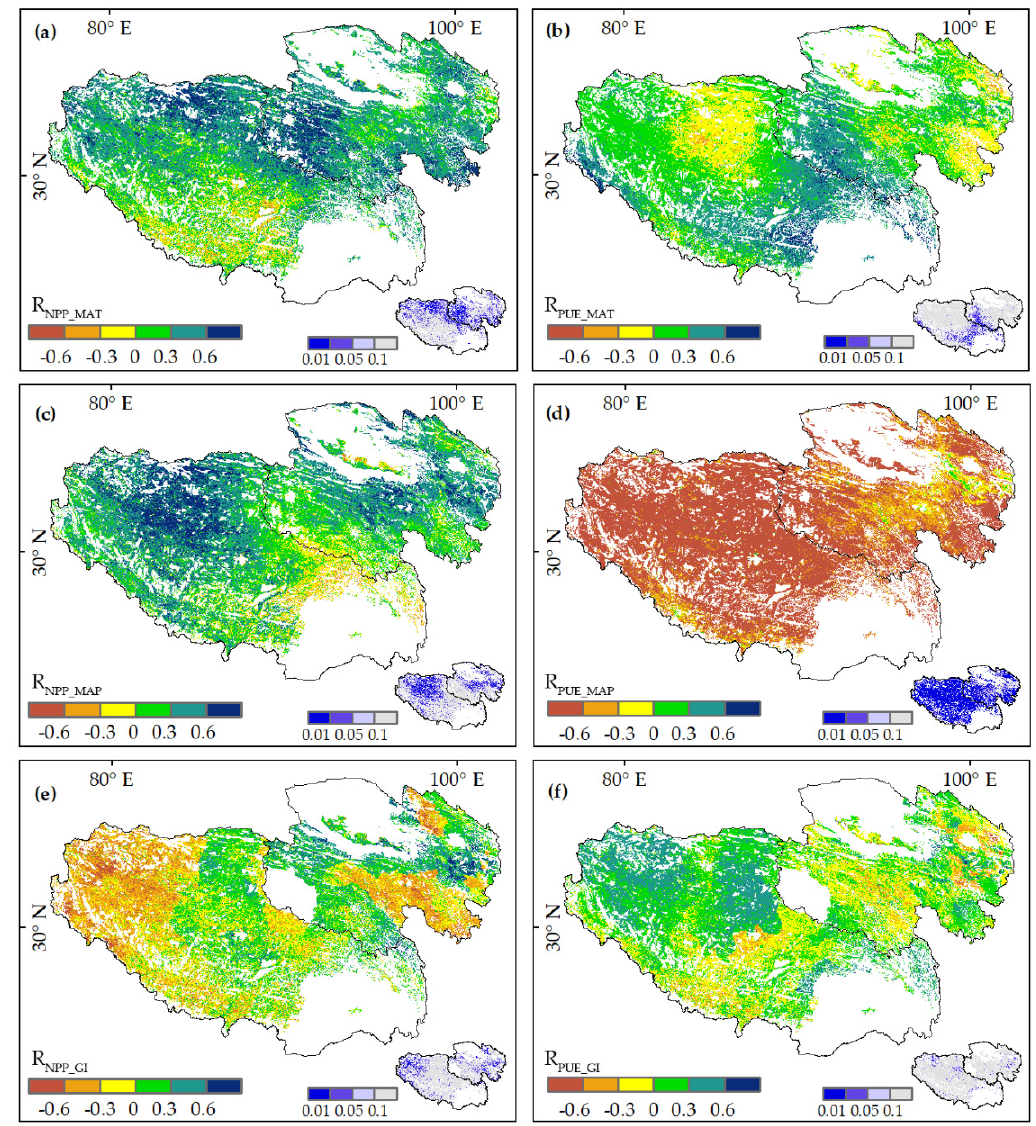
Figure 5. The correlation coefficients of MAT, MAP, and GI with grassland NPP ( a , c , e ) and PUE ( b , d , f ) during 2000–2017. Small maps at the bottom are the ranges of significance levels.